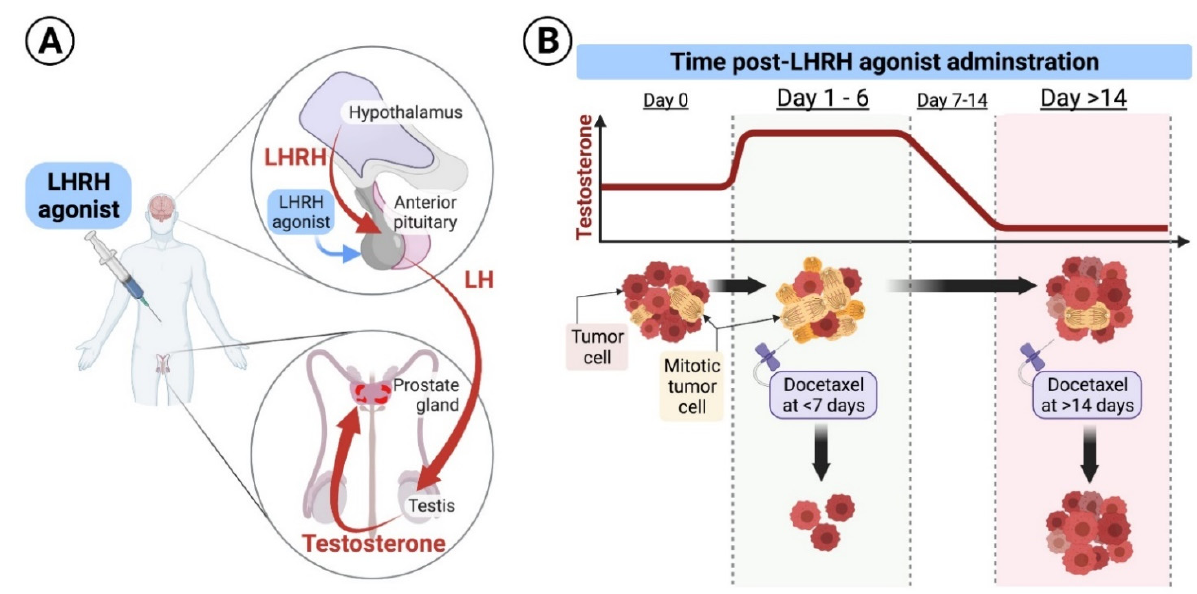
Figure 2. ( A ) Schematic diagram of the LHRH mode of action: Under physiologic conditions, the hypothalamus secretes luteinizing hormone-releasing hormone (LHRH) in a cyclic manner to induce secretion of luteinizing hormone (LH) from the pituitary, which results in secretion of testosterone from the testicles. LHRH agonists used for treatment of prostate cancer are formulated in long-acting and continuously released forms, that are injected subcutaneously and released to the systemic circulation at high levels for protracted periods of times, ranging from 1 to 6 months. Continuously released LHRH agonists mask the cyclic secretion of LHRH from the hypothalamus, leading to a drop in LH secretion from the pituitary and suppression of androgen secretion from the testicles. ( B ) Effect of docetaxel at different times of application: Upon initiation of long-acting for-